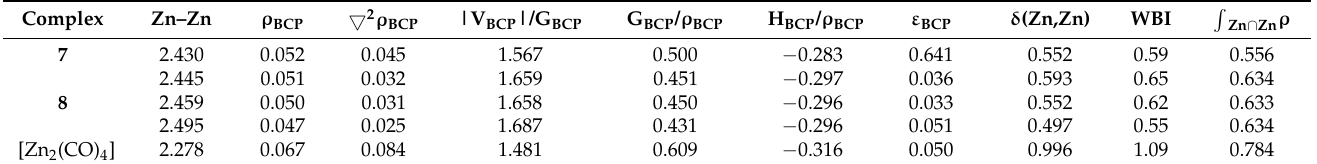
Table 4. Selected local and integrated topological properties of the electron density at the Zn–Zn BCP for complexes 7 , 8 and [Zn 2 (CO) 4 ] a .